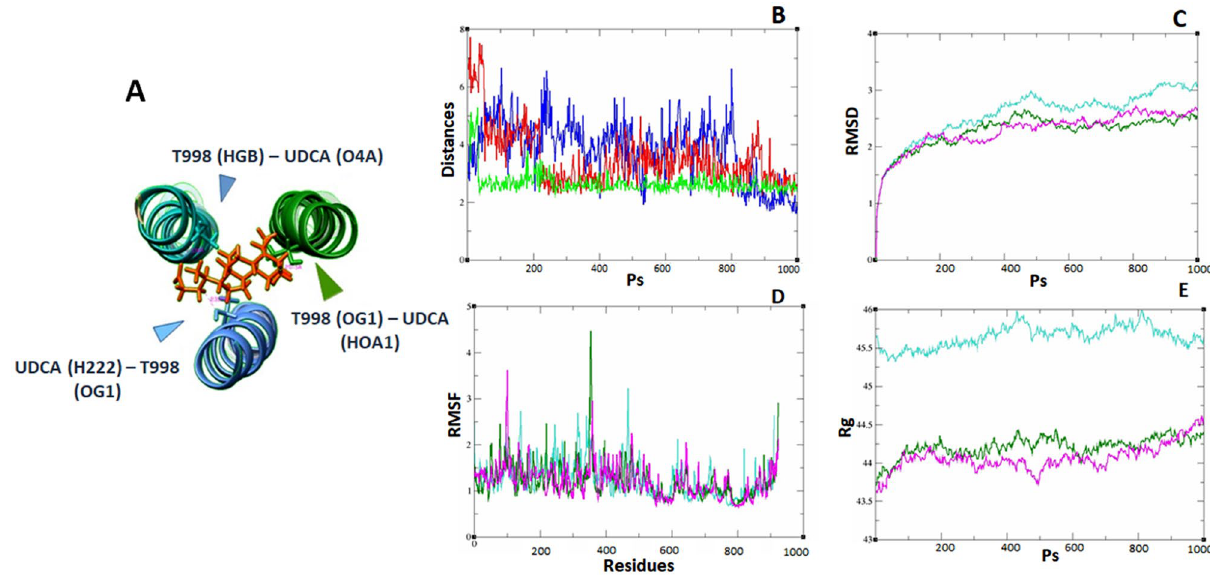
Figure 2. Schematic representation of UDCA in the central region of the alpha-helices. The UDCA—Spike protein interaction is maintained along the molecular dynamics’ trajectory due to the interaction of the bonds between the THR 998 atoms of monomers A, B, and C with UDCA. ( A ) UDCA interaction is shown with monomers A, B and C. UDCA in orange. Image edited with UCSF Chimera V 1.15. ( B ) The distances of the atoms that maintain this interaction are observed, the intervening atoms are shown in Table 2; blue line UDCA-T998 (chain B), red line UDCA-T998 chain C and green line UDCA-T998. ( C ) RMSD calculated by monomer (A, turquoise; B, green and C, magenta line) which shows stability in the simulation. ( D ) RMSF calculation, fluctuation of each residue per monomer (A, turquoise; B, green and C, magenta line) in the region of alpha helices, from lysine 986 to cysteine 1032. ( E ) Calculation of the radius of gyration that shows the degree of compactness of the monomers: A (45.64 ± 0.14; turquoise line) > B (44.21 ± 0.13; green line) > C (44.07 ± 0.17; magenta line).